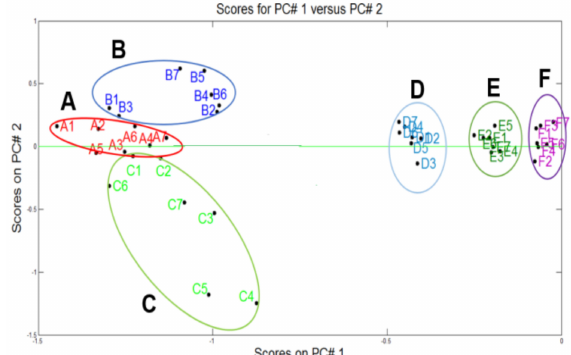
Figure 5. ( A ) Sterile water, ( B ) Output water of the aqueduct, ( C ) Tap water, ( D ) Water from sedimentation tank, ( E ) Input water of the aqueduct y ( F ) Escherichia coli .